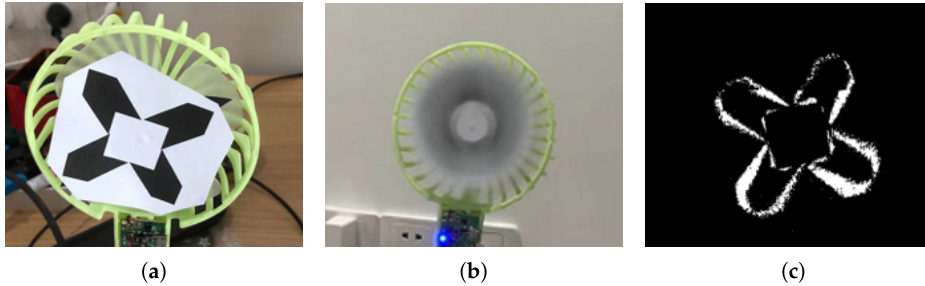
Figure 5. ( a ) shows the original image when the fan is stationary, ( b ) shows the image taken with an RGB camera; when the fan rotates at high speed, the picture can no longer be observed due to motion blur. ( c ) shows the event data taken with an event camera when the fan rotates at high speed; we visualize event data for comparison and a clear target structure without background is captured. It can be observed from this comparison diagram that the event camera can effectively avoid motion